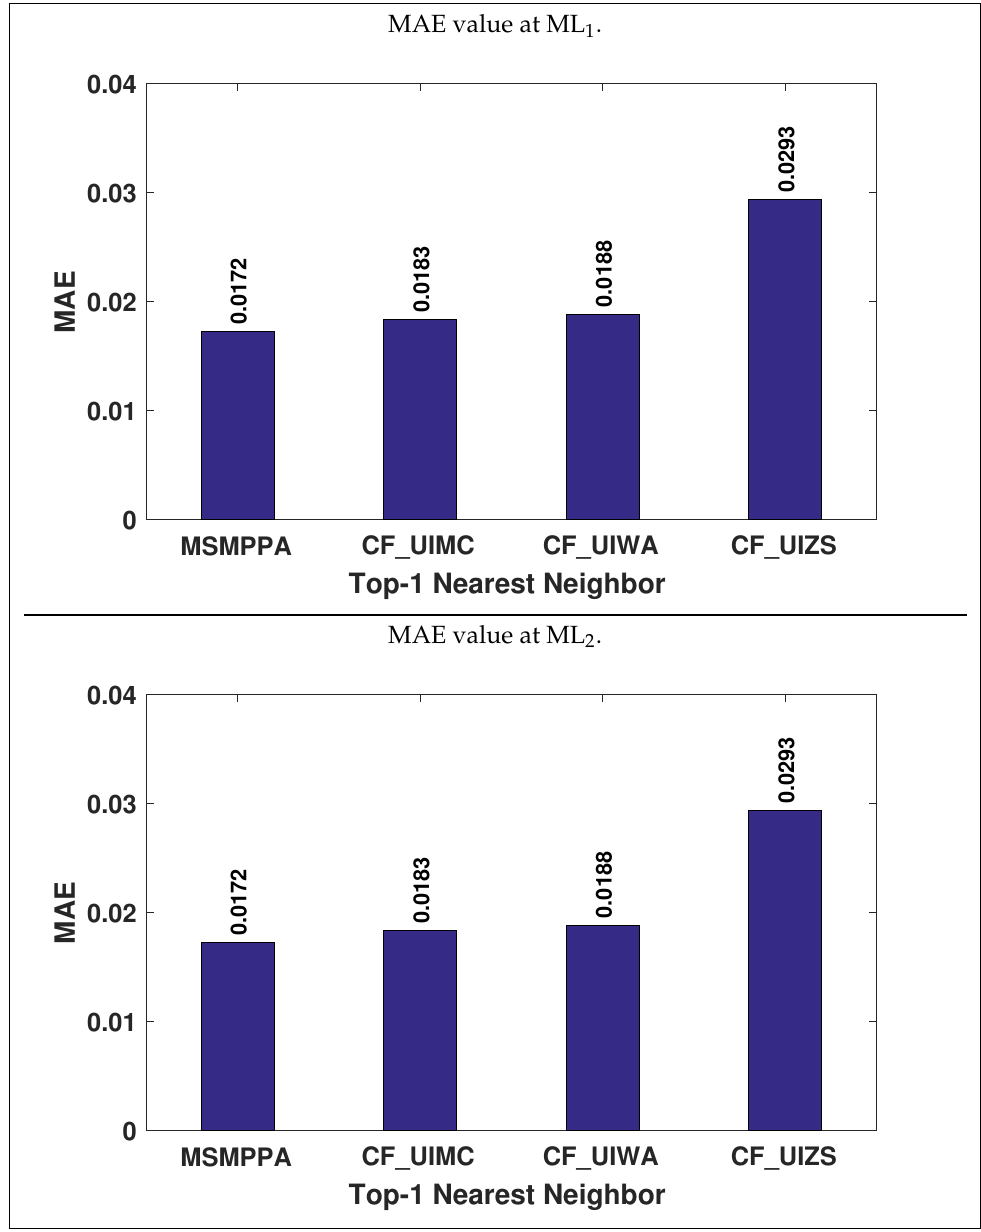
Figure 14. MAE Value at